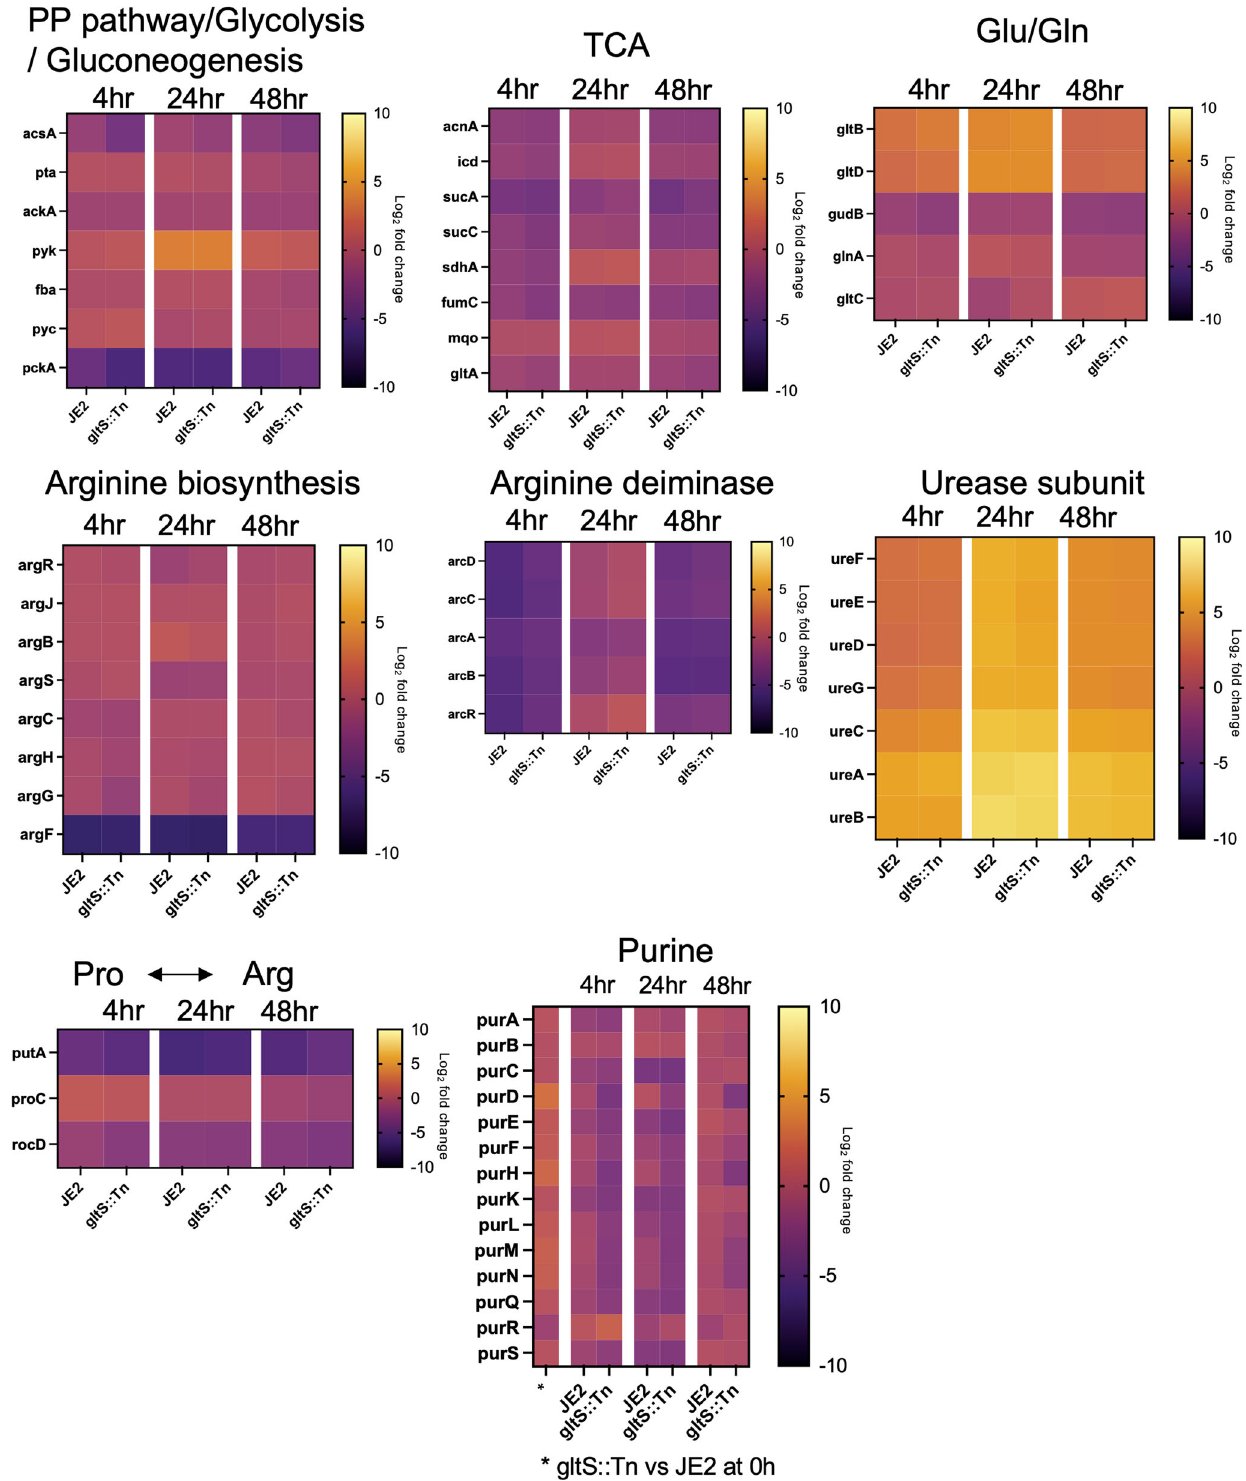
Fig. 6 RNA seq analysis of JE2 and gltS transposon mutant bio fi lm cells. Heat map showing the course of change in log 2 fold change at each time point referenced to the start of bio fi lm culture (0 h). The bar indicates log 2 fold change at each time point referenced to the start of bio fi lm culture (0 h).